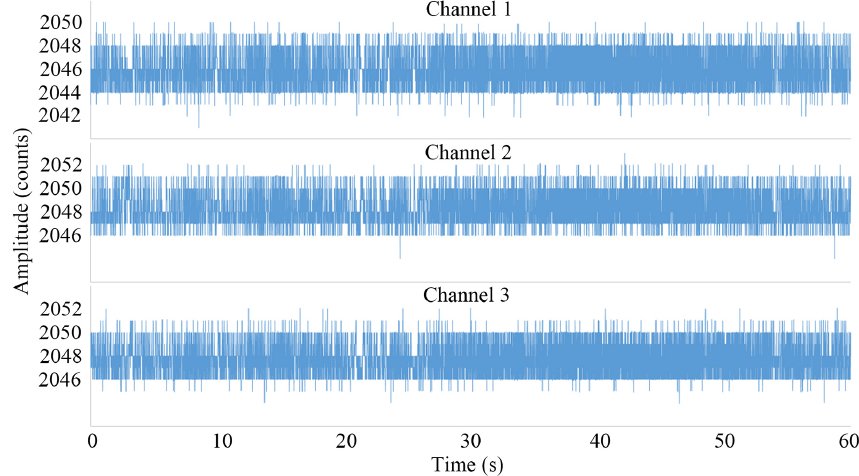
Figure 7. Internal noise measurements for each channel.